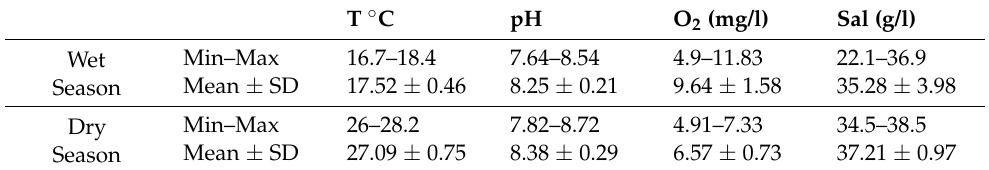
Table 2. Physicochemical parameters of the surface waters in the lagoon during the wet and dry seasons. T ◦ C pH O 2 (mg/l) Sal